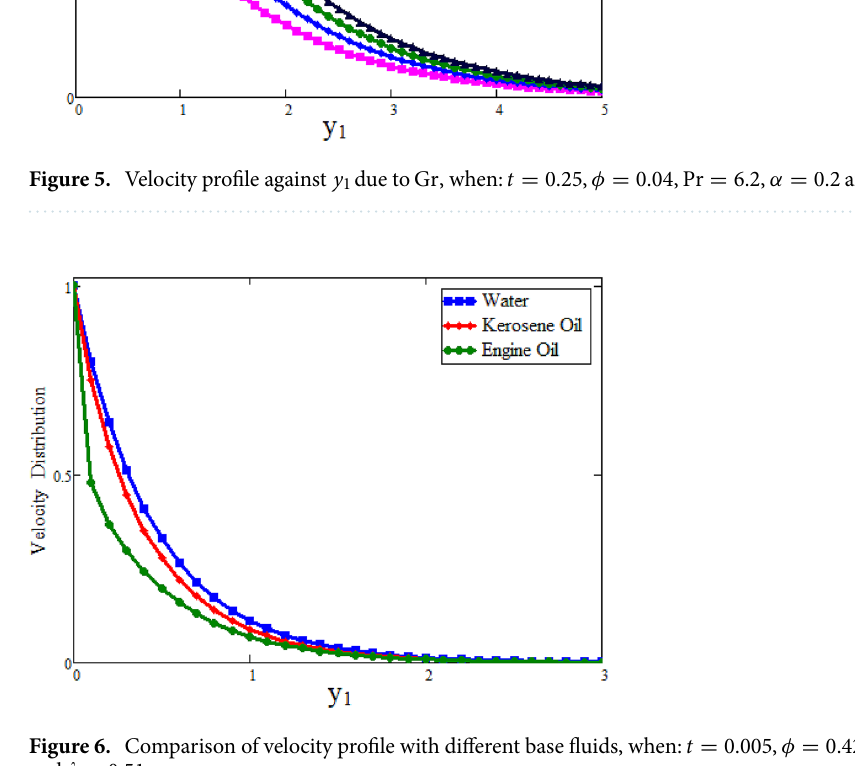
Figure 6. Comparison of velocity profile with different base fluids, when: t = 0.005 , φ = 0.42 , Gr = 5 , α = 0.1 and (cid:31) = 0.51.